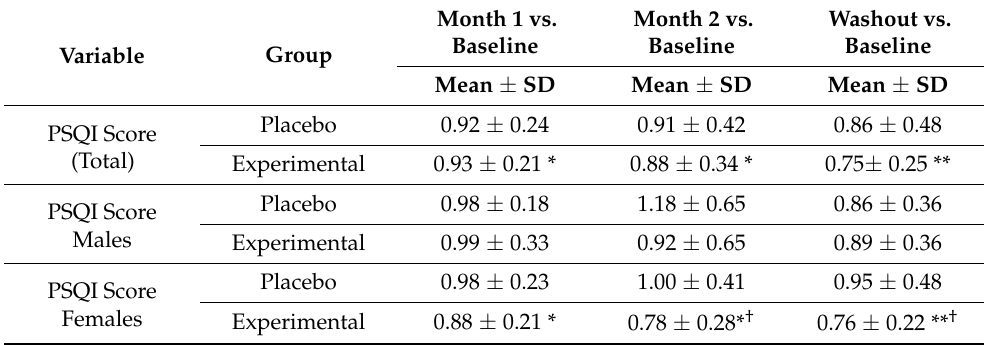
Table 7. Results of PSQI questionnaire. Change vs. baseline = percent change from baseline. Month 1 Variable Group